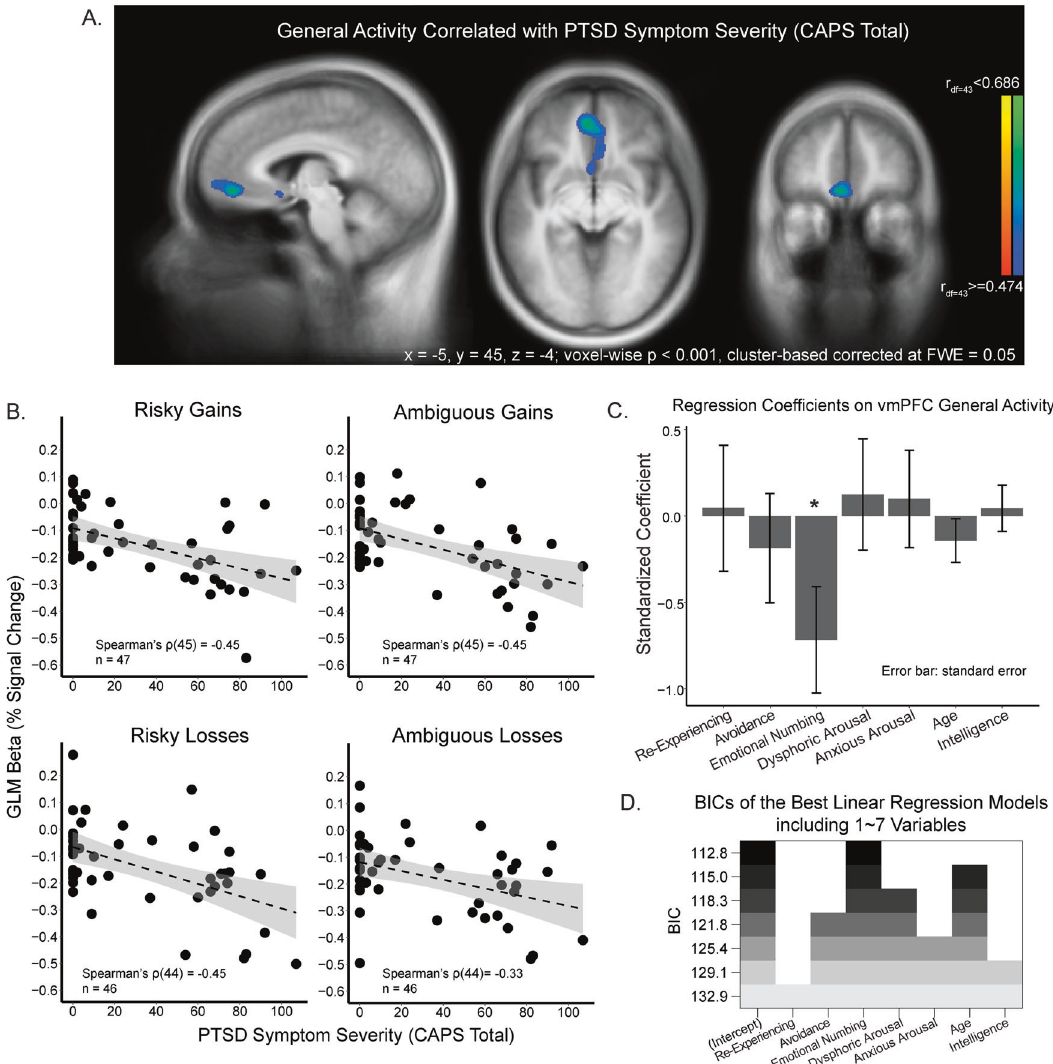
Fig. 3 Reduced vmPFC activity during valuation is related to PTSD symptom severity. A A whole-brain analysis revealed that activity in vmPFC during valuation was negatively correlated with CAPS total score, regardless of decision condition. B Visualization of this negative correlation between general activity in the vmPFC and CAPS total score in each decision condition. C Emotional numbing symptom severity drove the negative relationship between vmPFC neural activity and PTSD symptom severity, revealed by a linear regression model on the vmPFC activity including all clusters of the 5-factor model of CAPS. D Variable selection using exhaustive search also indicated that emotional numbing was the key symptom driving this relationship. Each row of the graph shows the selected variables (shaded) for the best model with a given number of predictors. Rows are ranked and colored by BIC. The top row represents the best model, which includes only Emotional numbing as the predictor, among all possible combinations of